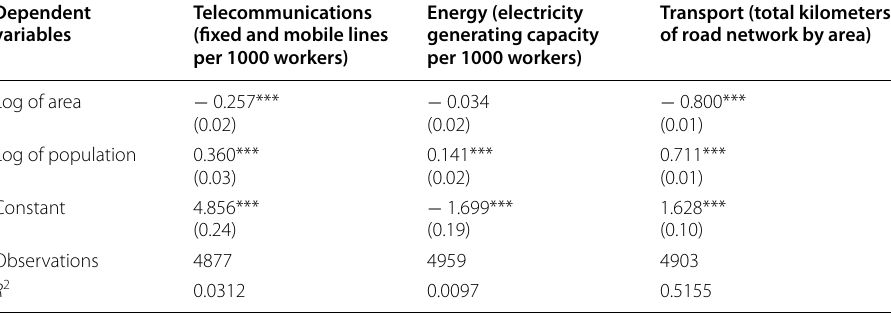
Standard errors in parenthesis *** Significant at 99%